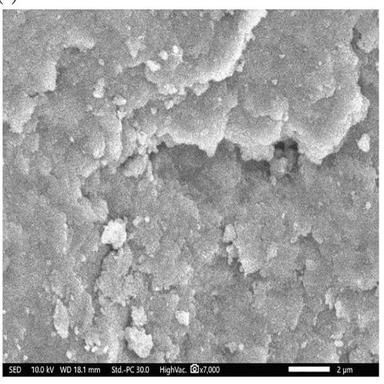
SEM images of (a) GO, (b) FG2I, and (c) FG2E.